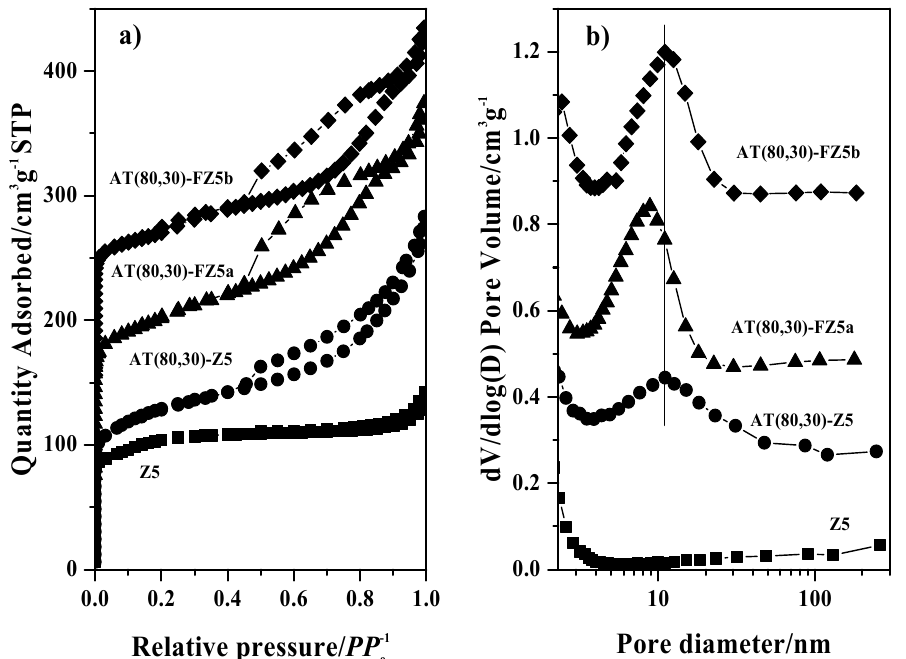
Figure 8. ( a ) N 2 adsorption-desorption isotherms of sequential fluorination-alkaline treated samples.